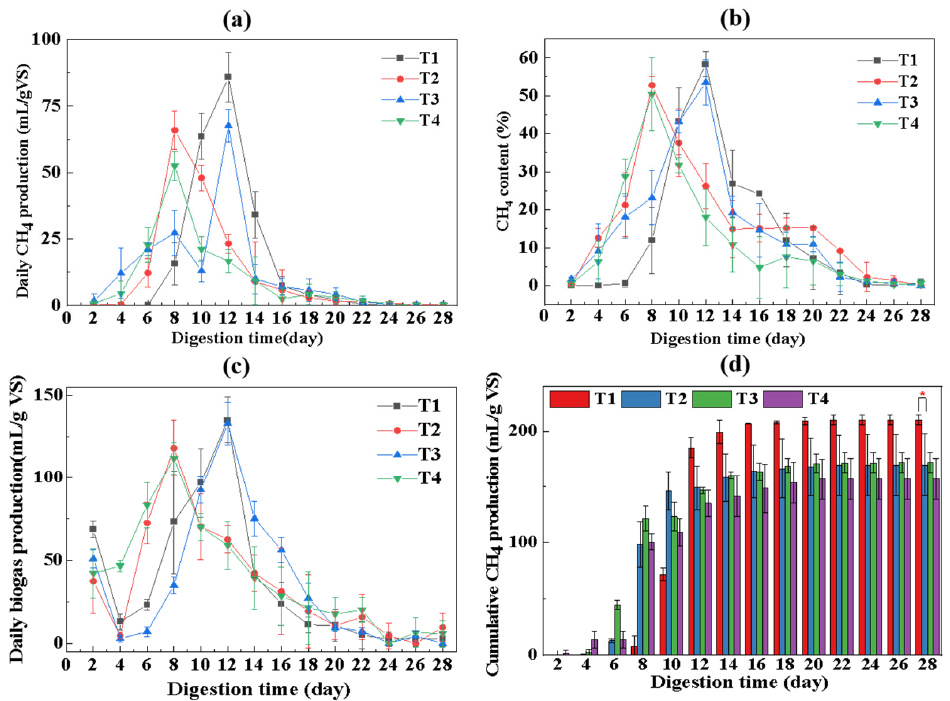
Figure 2. Comparison of F-CS and D-CS digester performance during AD, based on ( a ) daily methane production, ( b ) methane content, ( c ) daily biogas production, and ( d ) cumulative methane production. * p = 0.02 <